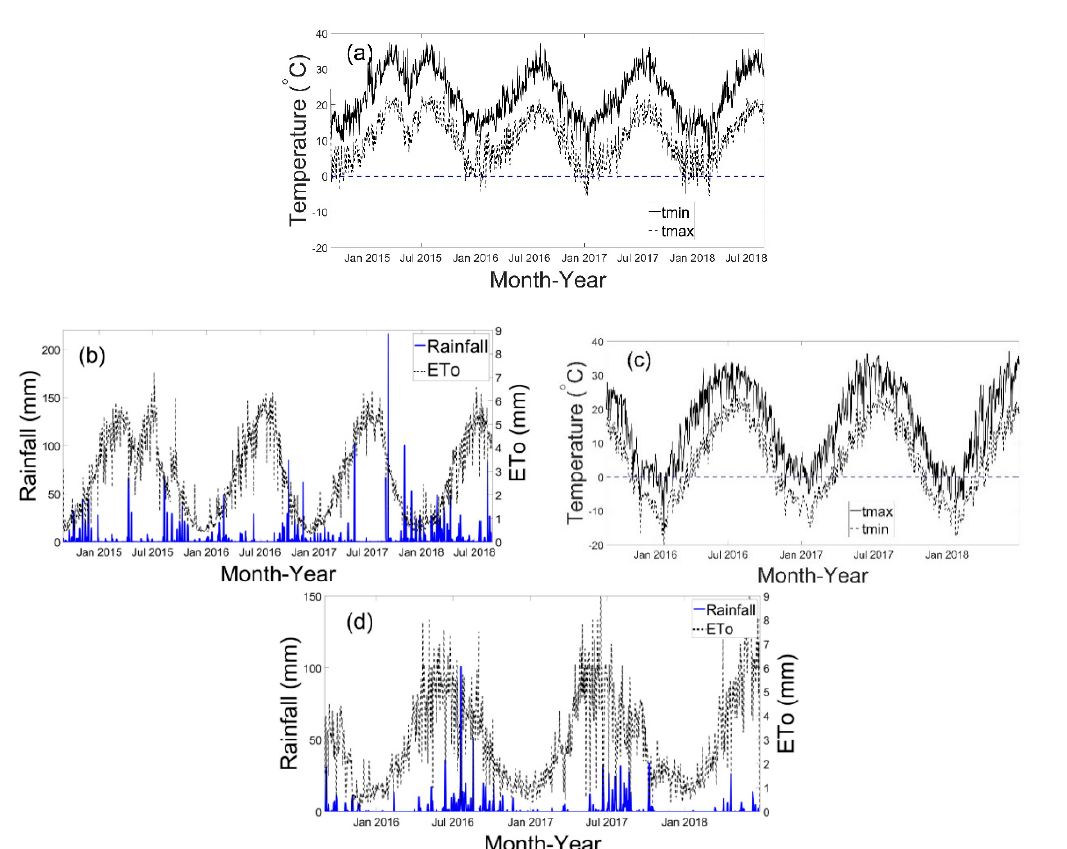
Figure 1. (a) Maximum and minimum temperature, (b) daily precipitation and reference evapotranspiration ( ET o ) for Maccarese, Central Italy. (c) Maximum and minimum temperature, (d) daily precipitation and reference evapotranspiration ( ET o ) for Xiaotangshan, China.